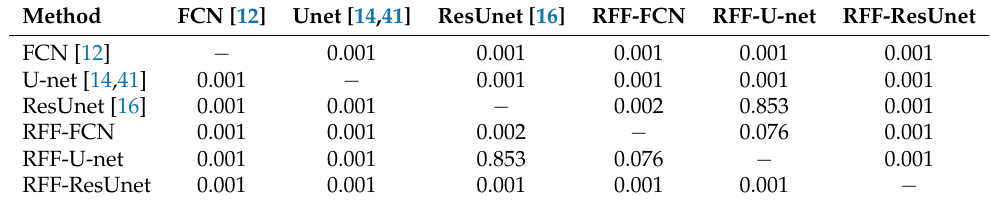
Table 2. Pair-wise post hoc analysis using the Friedman test concerning the Dice-based results in Table 1. The r , r (cid:48) element reports the p -value after the statistical comparison between models M r and M < 0.05, then statistical difference between approaches is accepted. r (cid:48) . If p -value